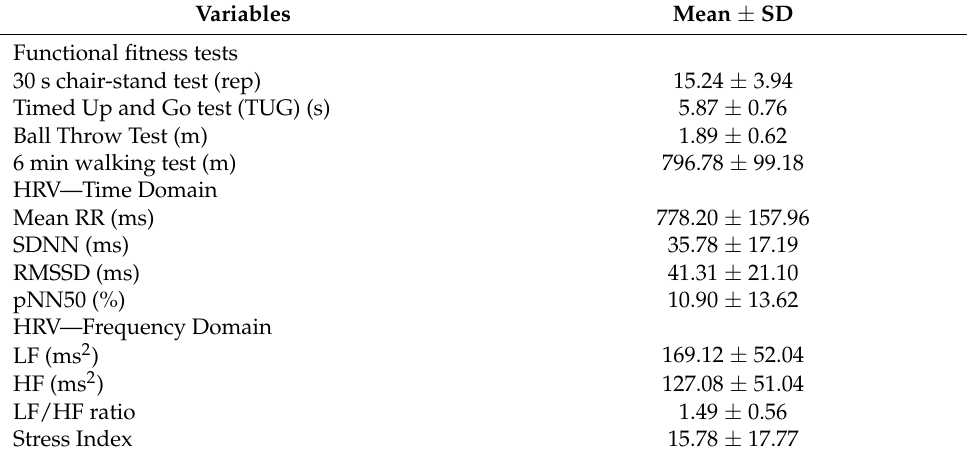
Table 3. Results of functional fitness tests and HRV